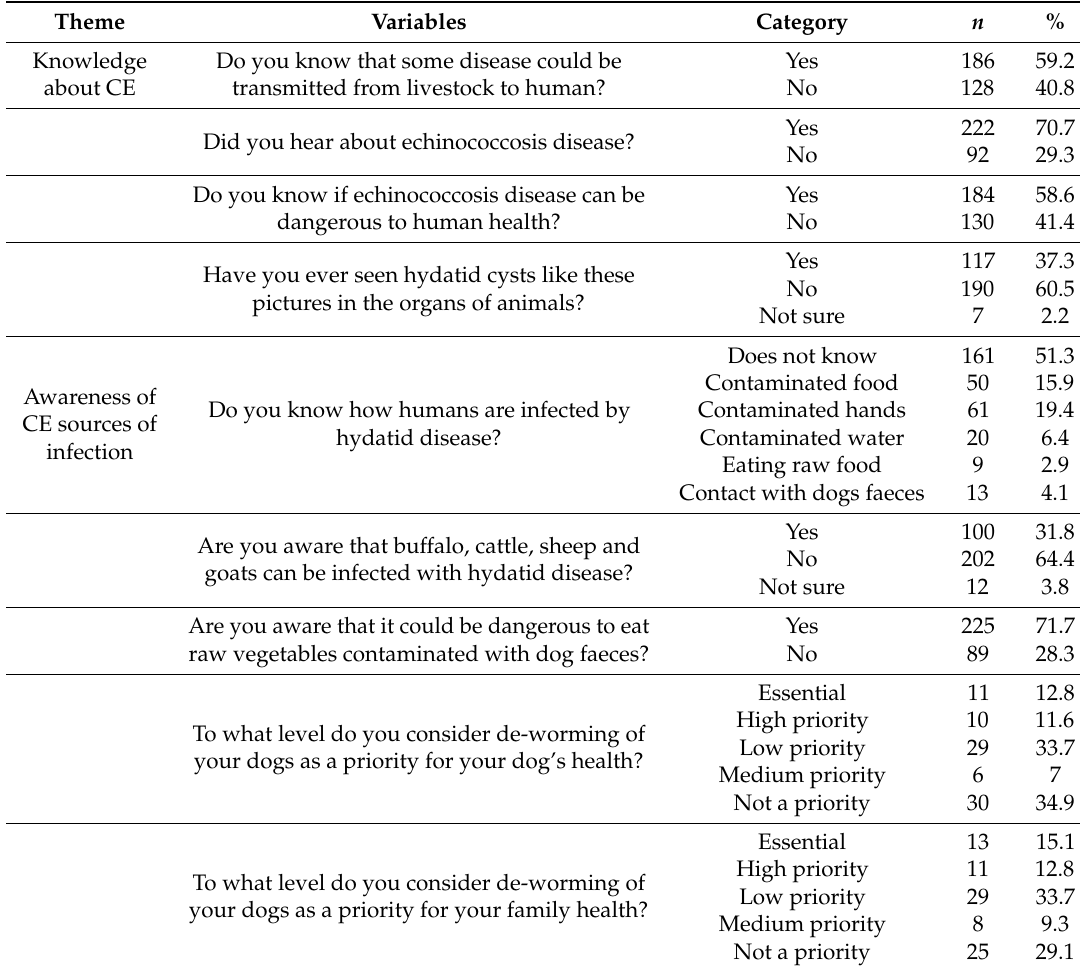
Table 3. Descriptive results of livestock farmers’ (N = 314) knowledge about and awareness of sources of infection with